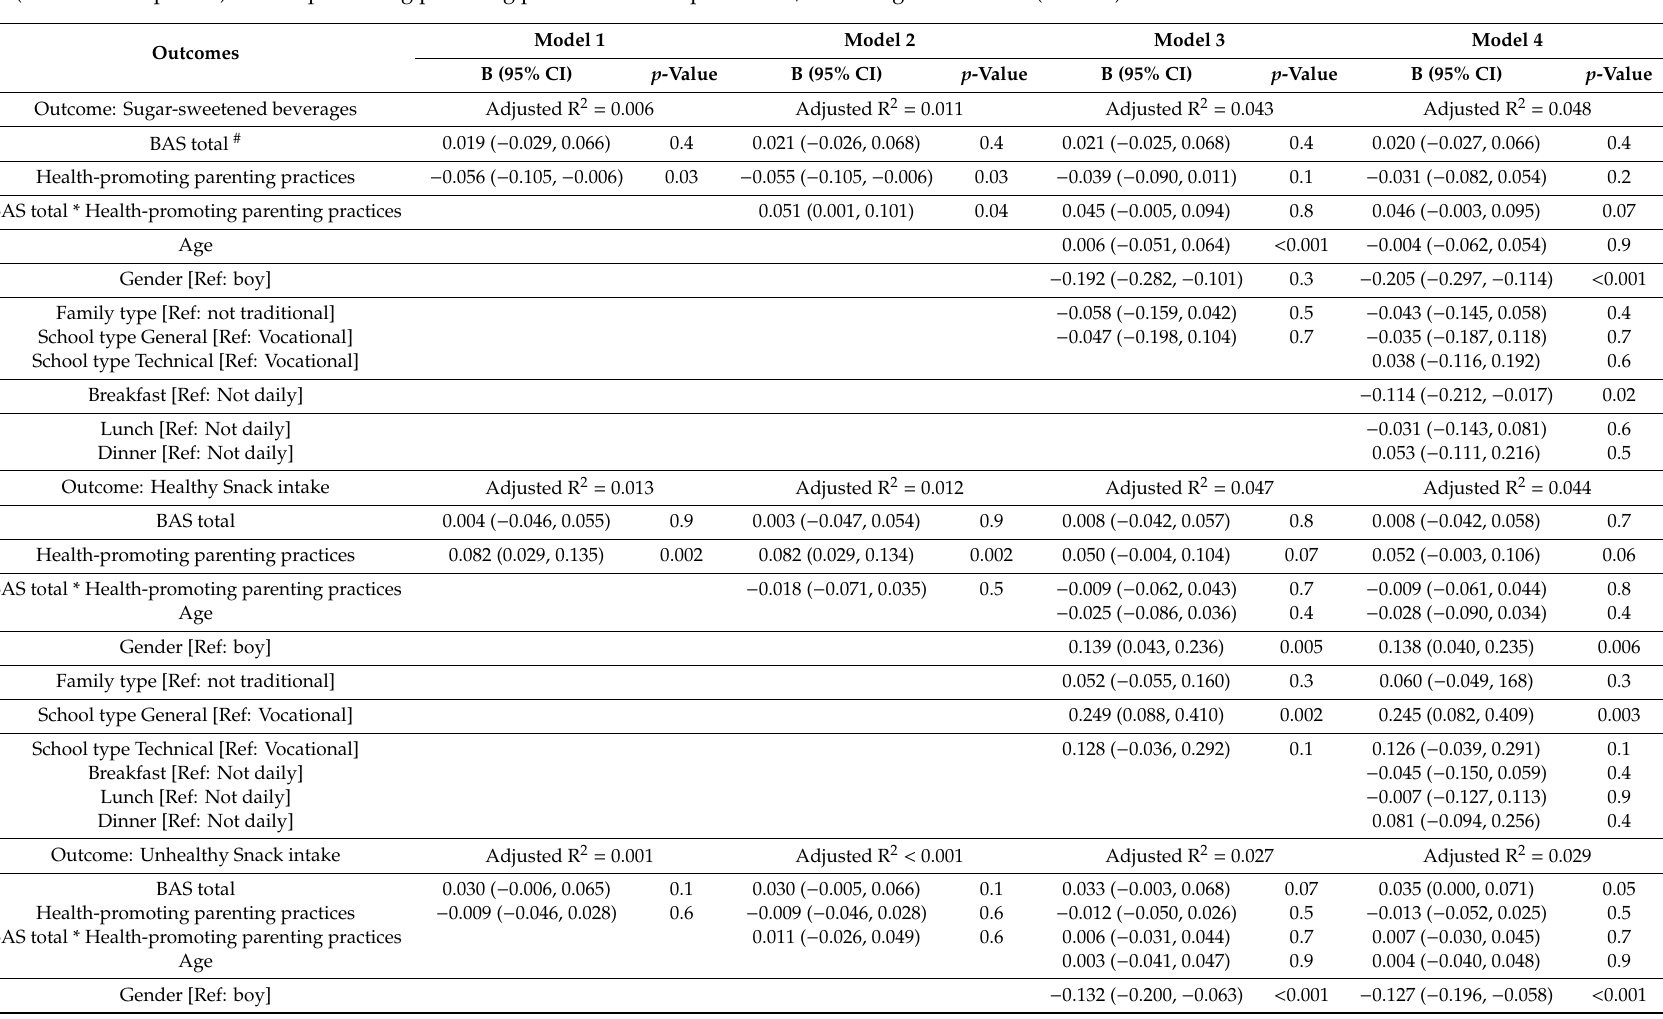
Table A3. Associations between reward sensitivity and adolescents’ intake of sugar-sweetened beverages, healthy and unhealthy snacks, and the moderating role of (adolescent-reported) Health-promoting parenting practices for complete cases, excluding diet outliers ( n =